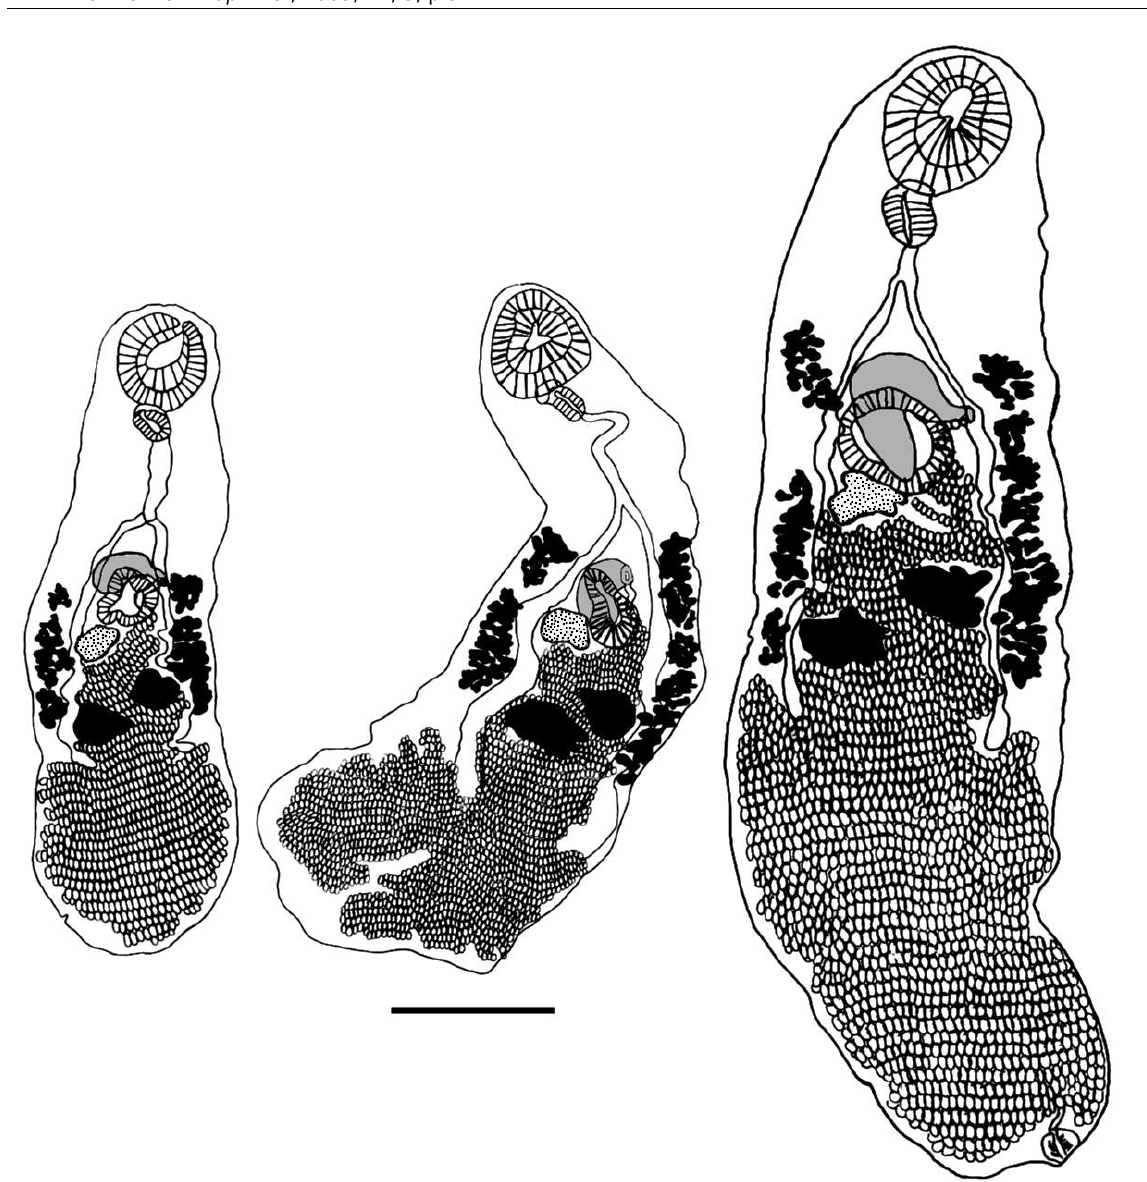
Figure 1. Haplometroides buccicola (Trematoda, Digenea, Plagiorchiidae) from the mouth and oesophagus of Phalotris lativittatus (Serpentes, Colubridae). (Bar scale=500 µ